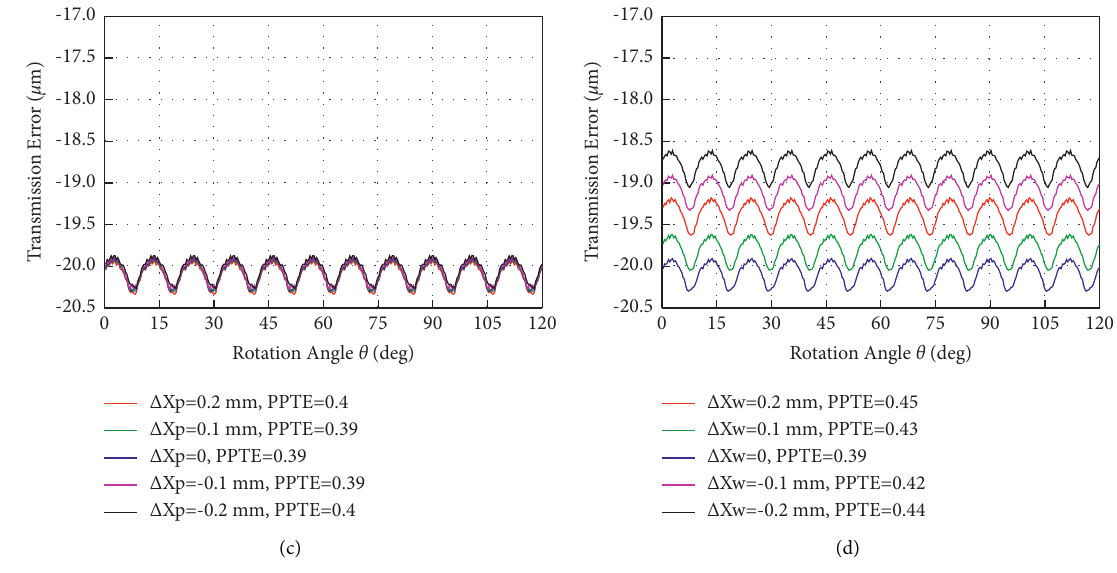
Figure 11: Time-varying transmission error. (a) Shaft angle deviation. (b) Offset deviation. (c) Pinion mounting distance deviation. (d) Wheel mounting distance